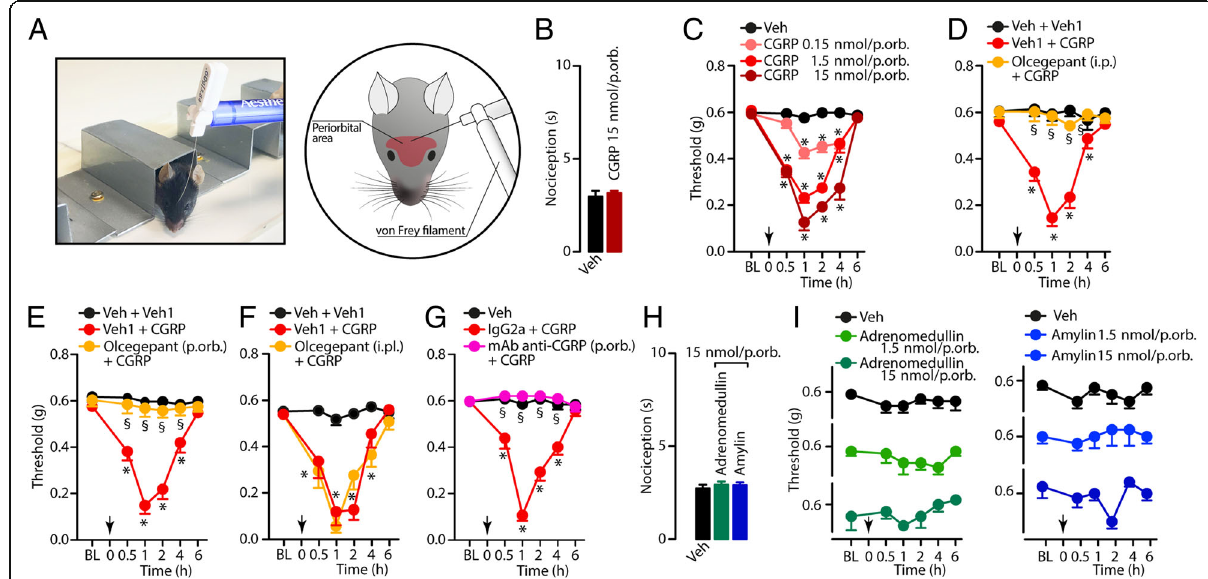
Fig. 1 a Photograph of restraint apparatus and von Frey monofilament used for evaluating periorbital mechanical allodynia (PMA) and drawing indicating the region where periorbital von Frey stimulus was applied during testing. b Subcutaneous injection in the periorbital area (p.orb., 10 μ l/15 nmol/site) of CGRP does not cause spontaneous nociceptive behaviour. c Dose- and time-dependent PMA evoked by p.orb. Injection of CGRP (10 μ l/0.15 – 15 nmol/site). d - f Effect of pretreatment with intraperitoneal (i.p. 1 μ mol/kg), p.orb. (10 μ l/4 nmol/site) and intraplantar (i.pl., 20 μ l/4 nmol/site) olcegepant on PMA evoked by CGRP (p.orb., 10 μ l/1.5 nmol/site). g Effect of pretreatment with a monoclonal anti-CGRP antibody (mAb anti-CGRP) or mouse monoclonal IgG2a (IgG2a) (both p.orb., 10 μ l/60 pmol/site) on PMA evoked by CGRP (p.orb., 10 μ l/1.5 nmol/ site). Adrenomedullin or amylin injection (p.orb., 10 μ l/1.5 – 15 nmol/site) does not evoke spontaneous nociceptive behaviour ( h ) or PMA ( i ).